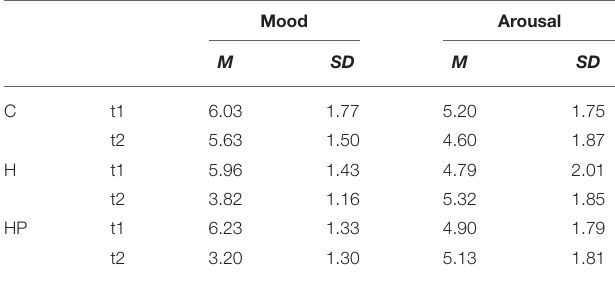
TABLE 5 | Participants’ mood and arousal at two different times (t1, t2) by